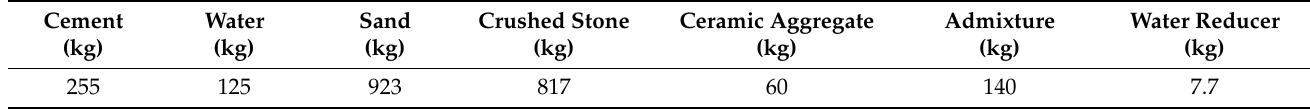
Table 2. Mix proportion of ceramsite concrete.